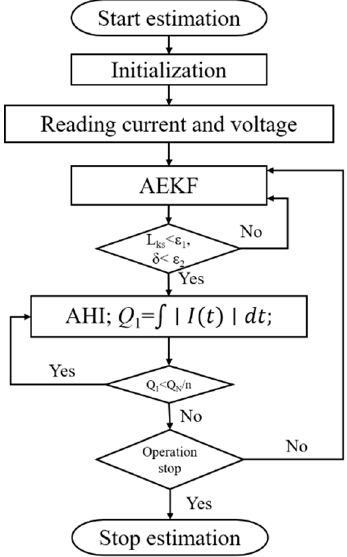
Figure 6. Flowchart of the proposed approach for SOC estimation.